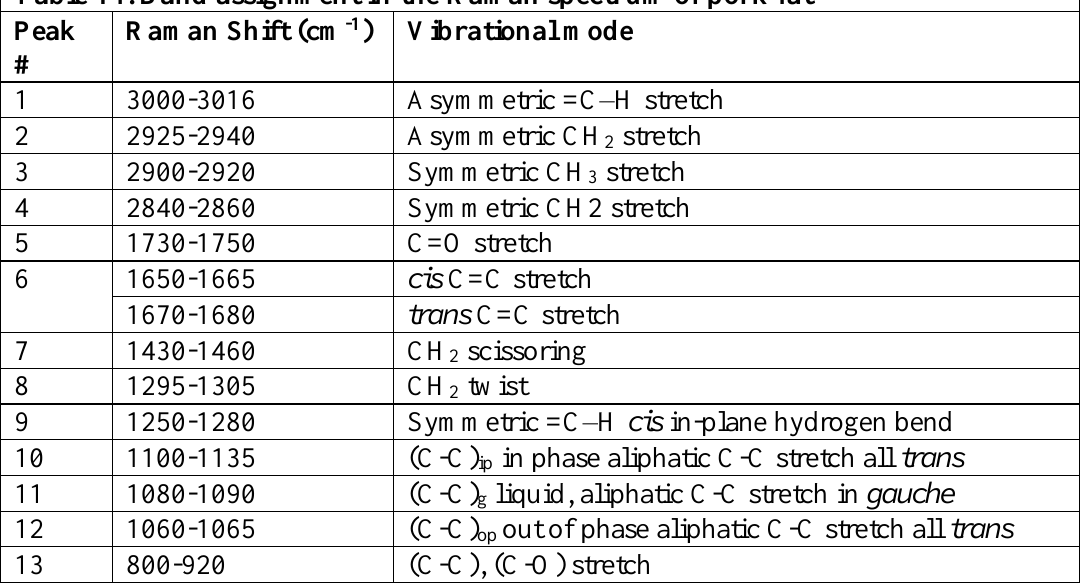
Table 14. Band assignment in the Raman spectrum of pork fat